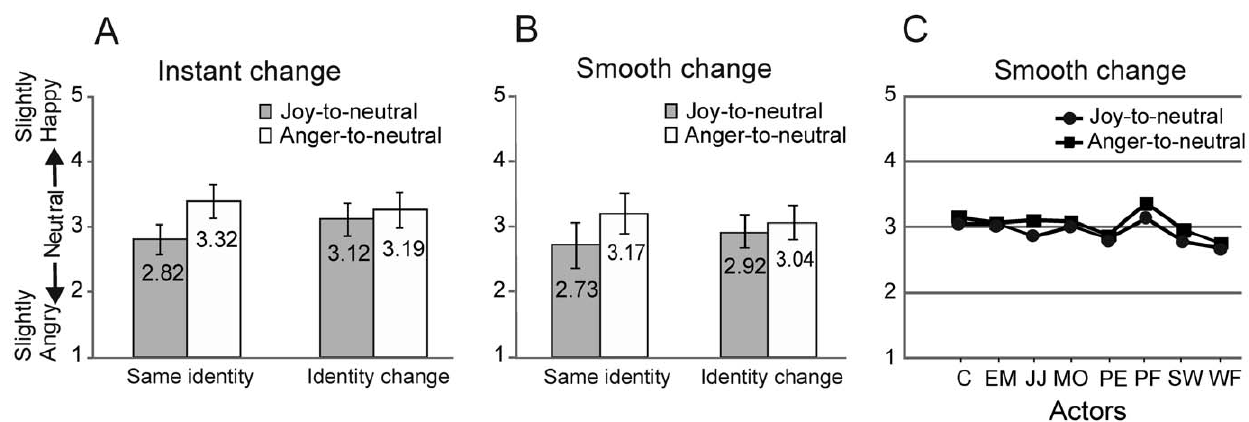
Figure 4. Results of Experiment 2. (A) Instant identity-change. Scores for the neutral expressions at the end of the joy-to-neutral and anger-to- neutral sequences in the same-identity and instant identity-change conditions. (B) Smooth identity-change. Same as in (A) but for the smooth identity-change condition. Error bars indicate 6 1SD. (C) Ratings for each of the eight actors in the smooth identity-change condition to illustrate the response consistency across actors. doi:10.1371/journal.pone.0056003.g004 point scale. Following eight practice trials, one experimental block was presented with 96 randomized trials (8 actors 6 2 perceptual histories 6 2 conditions 6 3 repetitions). The participant’s task was